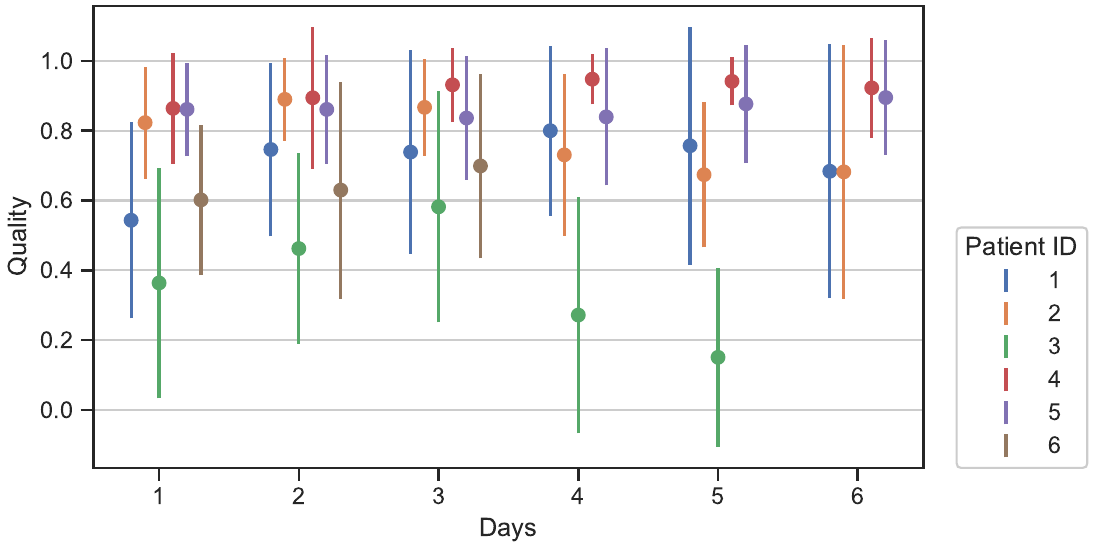
Figure 10. Data quality over time for all patients. Some patients have fewer days due to data